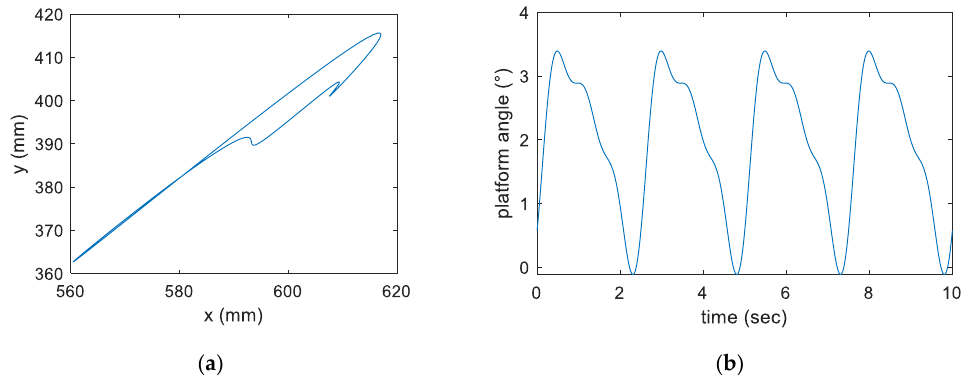
Figure 7. Exciting trajectory: ( a ) position and ( b ) angle. Appl. Sci. 2020 , 10 , x FOR PEER REVIEW